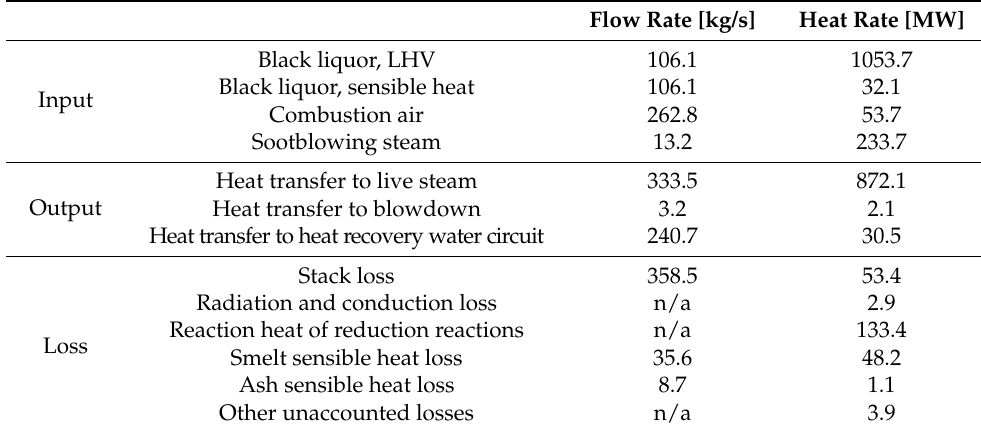
Table 2. Summary of the modeled recovery boiler heat inputs, outputs, and